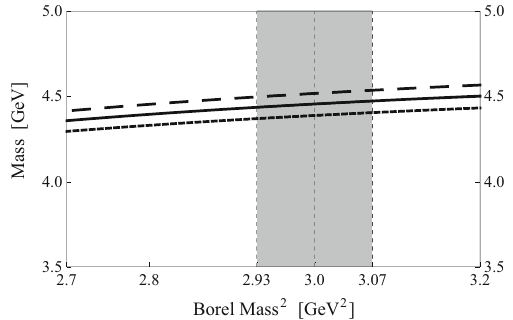
Fig. 2 The variation of M X with respect to the Borel mass M B , cal- culated using the current η 2 . The short-dashed, solid, and long-dashed curves are obtained by setting s 0 = 24 . 8, 25 . 8, and 26 . 8 GeV 2 , respec-